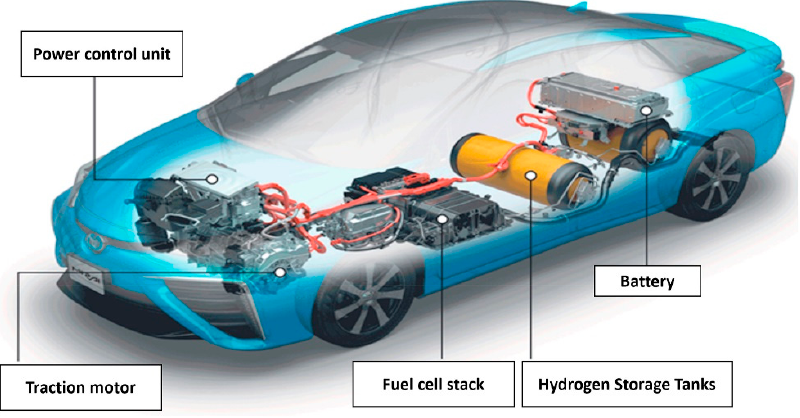
Figure 5. Part of the fuel cell Toyota Mirai [27]. Republished with permission from Elsevier (License no: 5416381285587).